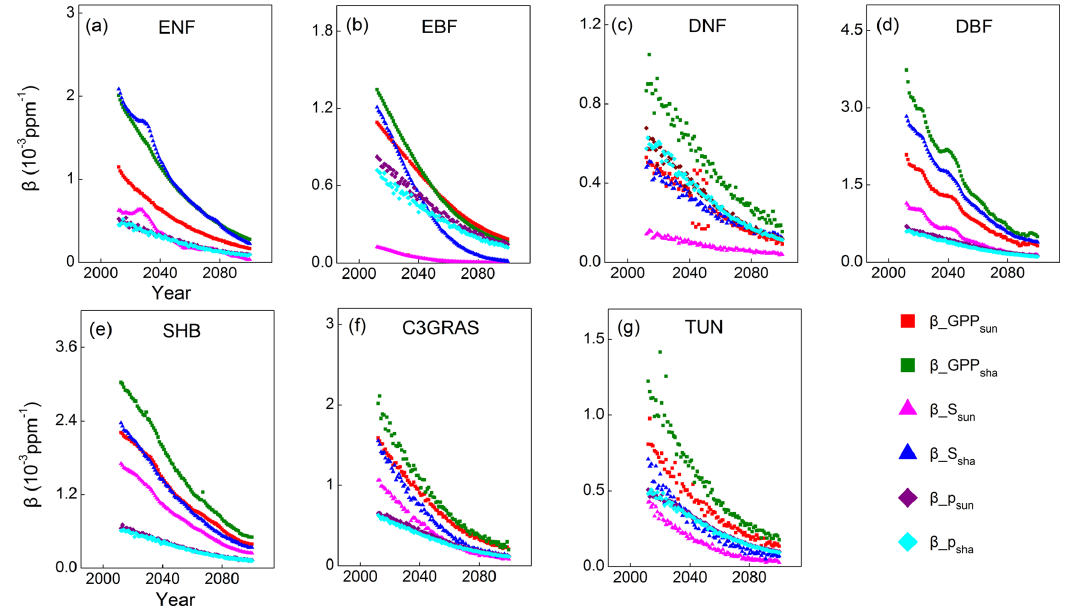
Figure 6. Temporal trends of β GPP (sensitivity of sunlit leaf GPP; red squares), β GPP (sensitivity of shaded leaf GPP; green squares), sun sha β S (sensitivity of scaling fatcor for sunlit leaf; pink triangles), β S (sensitivity of scaling fatcor for shaded leaf; dark blue triangles), sun sha β p (photosynthetic response for sunlit leaf; purple diamonds) and β p (photosynthetic response for shaded leaf; sky blue diamonds) sun sha for C 3 PFTs from CABLE-C-only simulation. The sensitivities of GPP sun and GPP sha tend to approach zero through time because the decomposing factors β p , β p , β S and β S all decline with time. β S determines the magnitudes and trends of β GPP sun sha sun sha sha PFTs. Abbreviations are the same as Fig.